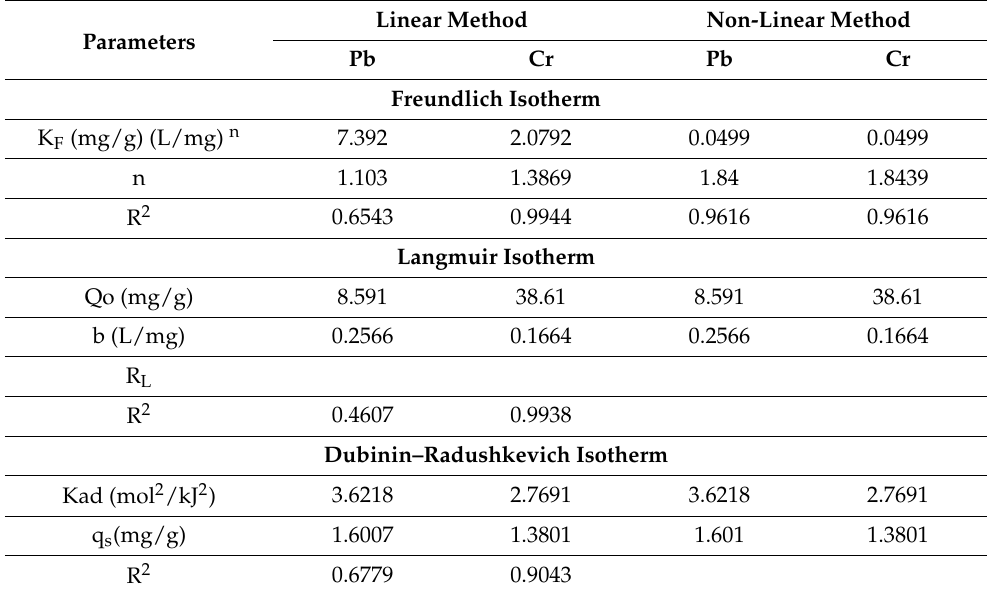
Table 5. Linear and non-linear parameters of isothermal models for biosorption of Pb and Cr on defatted seed residue of C. melo.